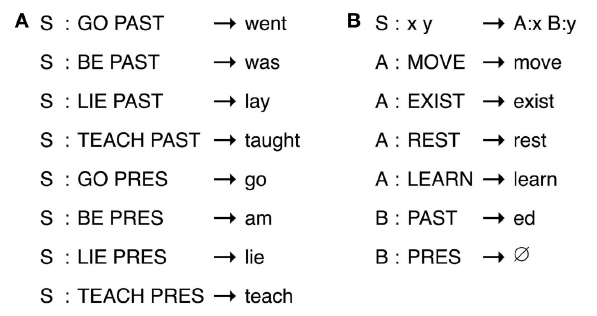
FIGURE 4 | Two simple transducers that map between a subset of the English verbs and their meanings, where “S” is the start symbol for the transducers and meanings are given in caps after a colon in each rule. Transducers can be holistic , essentially a dictionary of meaning-signal pairs (A) ; or compositional , in which the meaning of a signal is composed of the meaning of parts of that signal (B)